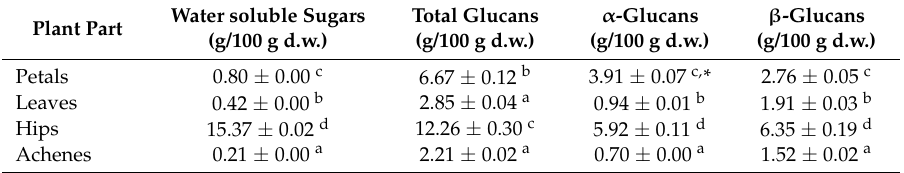
Table 1. Content of water-soluble sugars, total glucans, α - and β -glucans in R. rugosa organs (g/100 g of dry weight) and sugar, protein in polysaccharide-rich fractions (% of crude polysaccharide) and total phenolic content (gallic acid equivalents (GaE) per g of CPL.